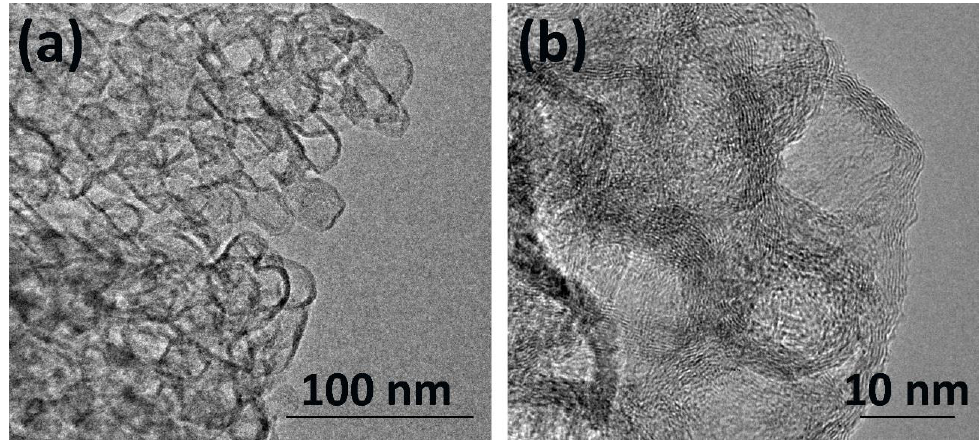
Figure 1. TEM images of GNFs ( a ) and oxidized GNFs_ox ( b ). The Raman spectra of carbon materials typically contain two main lines. The D line at ~1360 cm − 1 relates to the radial-breathing mode A lg of aromatic C6 rings in the graphene plane with conjugate sp 2 -carbon atoms. This mode can be resonantly excited under π -electrons’ optical transition in the corresponding graphene clusters. The G band at 1581 cm − 1 corresponds to E 2 g stretching vibrations of C6 rings in the graphene plane. All the samples had three 2D overtones at 2700 cm − 1 , (D + G) at 2960 cm − 1 , and 2G at ~3200 cm − 1 in their Raman spectra due to the small size of the graphitic domains [36] and the curvature of the carbon layers [37]. At the same time, 2D, (D + G), and 2G overtones were observed in the Raman spectrum of graphene [38]. The defectiveness of the GNFs and GNFs_ox was estimated through the Raman spectra as the ratio of intensities of D and G lines I D /I G (Figure 2). The ratios of I D /I G of GNFs, GNFs_ox, and GNFs_ox_400 were 0.88, 0.90, and 0.86, which clearly indicated an increase in the defectiveness of the samples after their oxidation and a decrease in their defectiveness after the heat treatment.